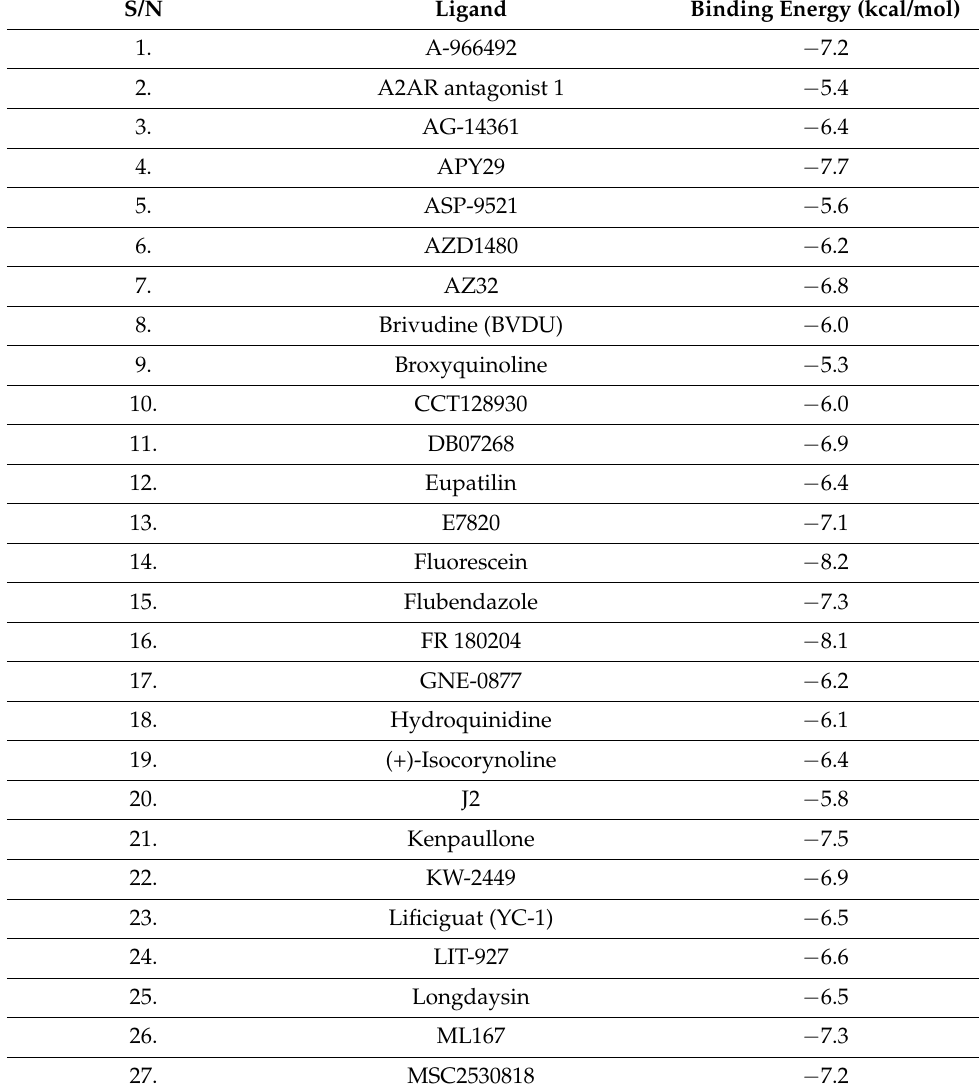
Table 2. The docking-derived binding affinity of anticancer compounds with good drug-like proper- ties against